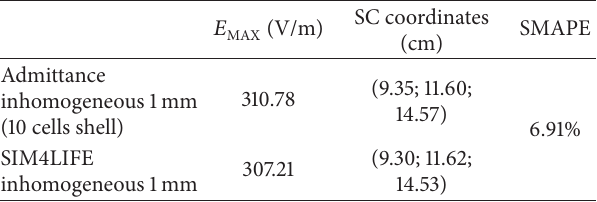
⃗𝐸| Table 1: Maximum | ( 𝐸 ), stimulation center (SC) coordinates, MAX and SMAPE calculated for the inhomogeneous brain model with 1mm resolution and a shell of 10 mesh cells and calculated with the commercial code SIM4LIFE for the inhomogeneous brain model with a regular 1mm mesh